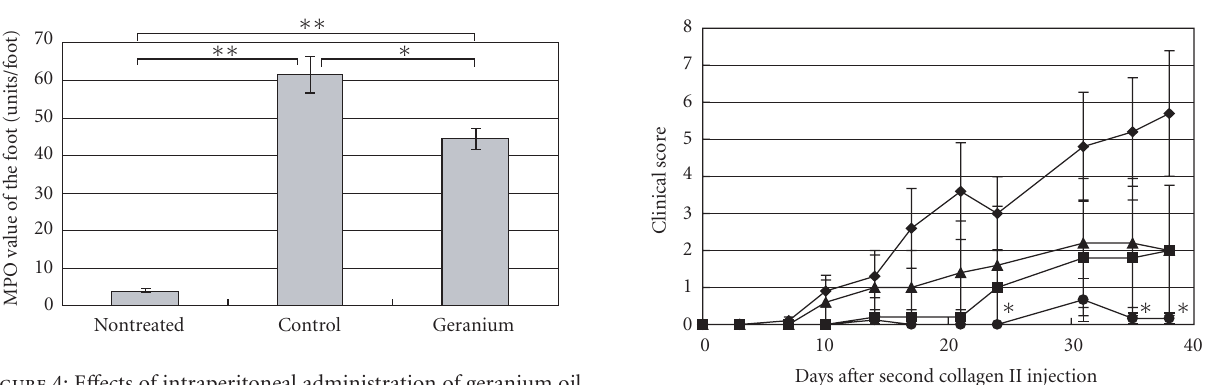
Figure 4: E ff ects of intraperitoneal administration of geranium oil on MPO activity in foot homogenates. Carrageenan was injected to left footpad of mice, and 10 minutes after the injection, geranium oil or DMSO was given intraperitoneaouly. Twenty four hours later, their feet were resected to measure their MPO activities. Each value represents an average from 5 mice and the standard error. ∗ P < . 05, ∗∗ P < . 01 di ff erence from control.